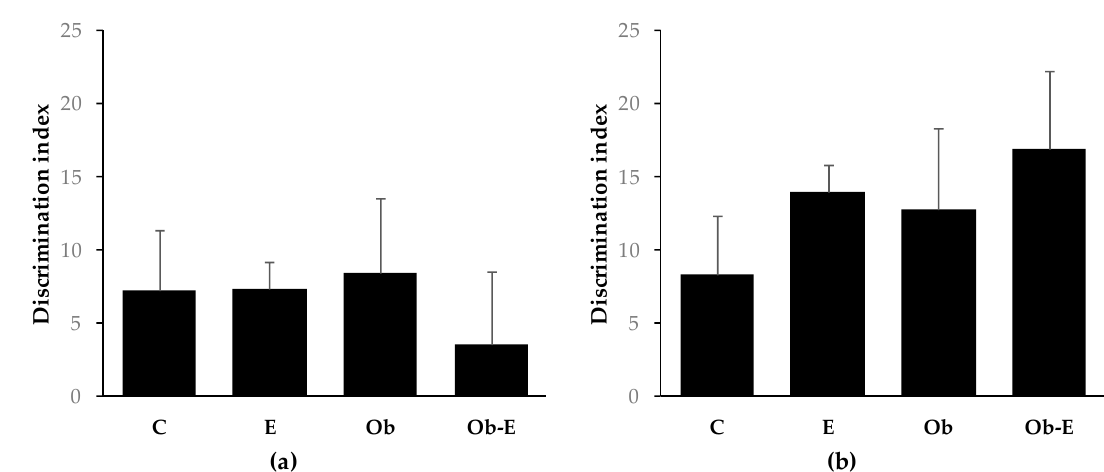
Figure 2. Effects of chronic ethanol exposure on wild-type and Ob mice in the object memory recognition task. Bars represent the mean ± SEM of the discrimination index evaluated at 1 h (short-term memory) ( a ) and 24 h (long-term memory) ( b ). Discrimation index is defined as DI = [(t novel − t familiar )/(t novel + t familiar ) × 100%]. C, wild-type control; E, wild-type ethanol; Ob, Ob control; Ob-E, Ob–ethanol.